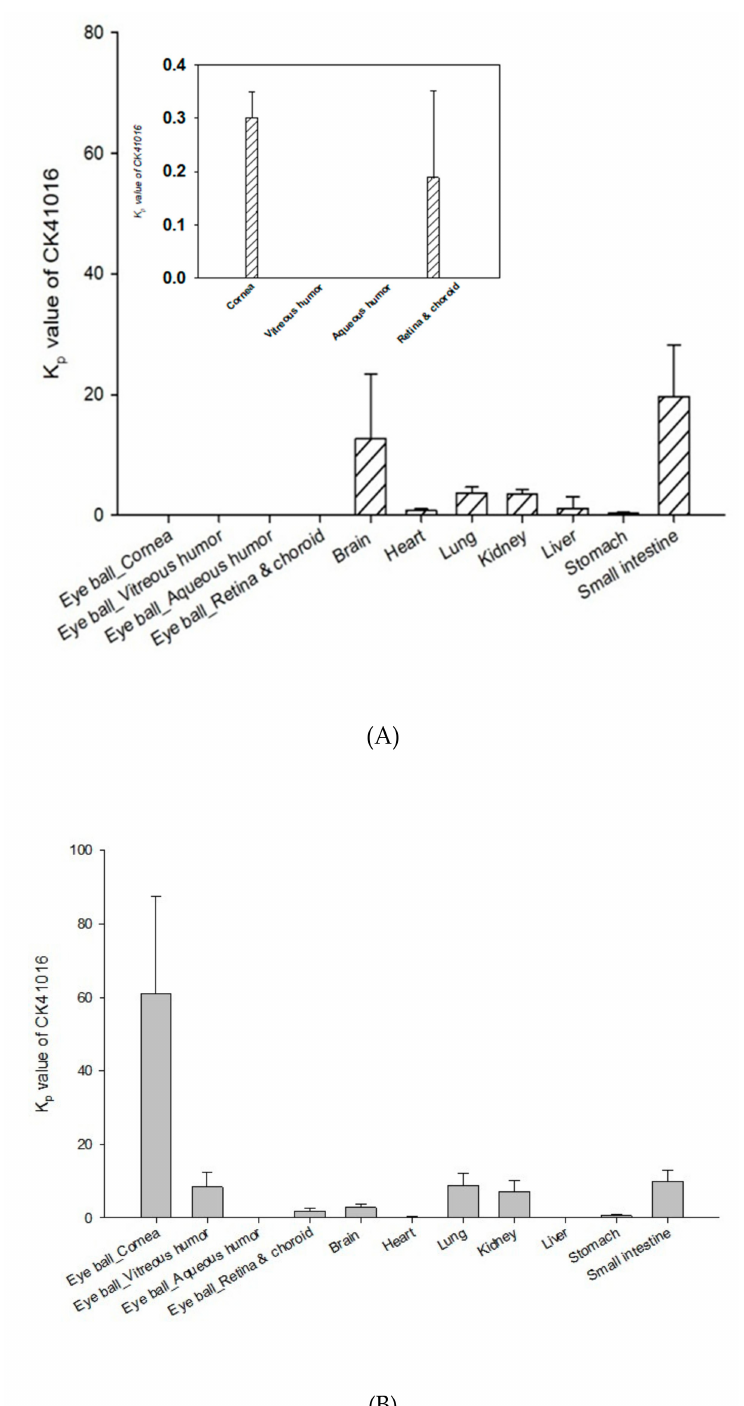
Figure 8. Mean Kp value of CK41016 in rabbit tissues at 240 min after IV ( A ) or eye drop administration ( B ) (mean ± SE, n =